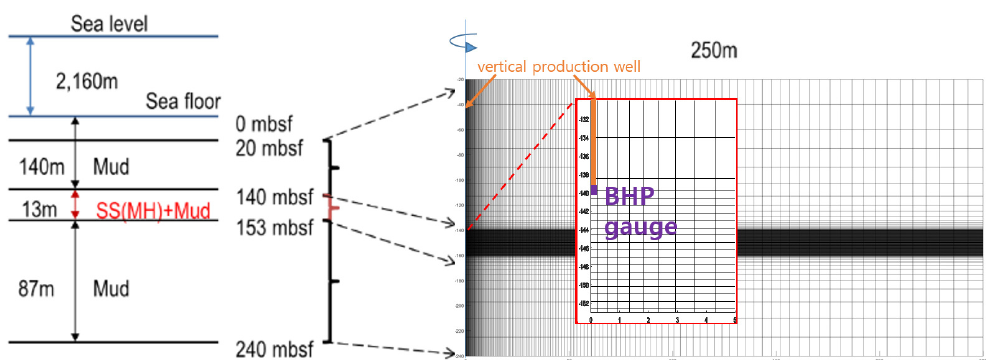
Figure 4. ( left ) A schematic geological layer information of the hydrate deposit (the reservoir region with intercalated layers colored in red) in between the overburden and underburden muds, and ( right ) the numerical domain used for simulation as in [3].